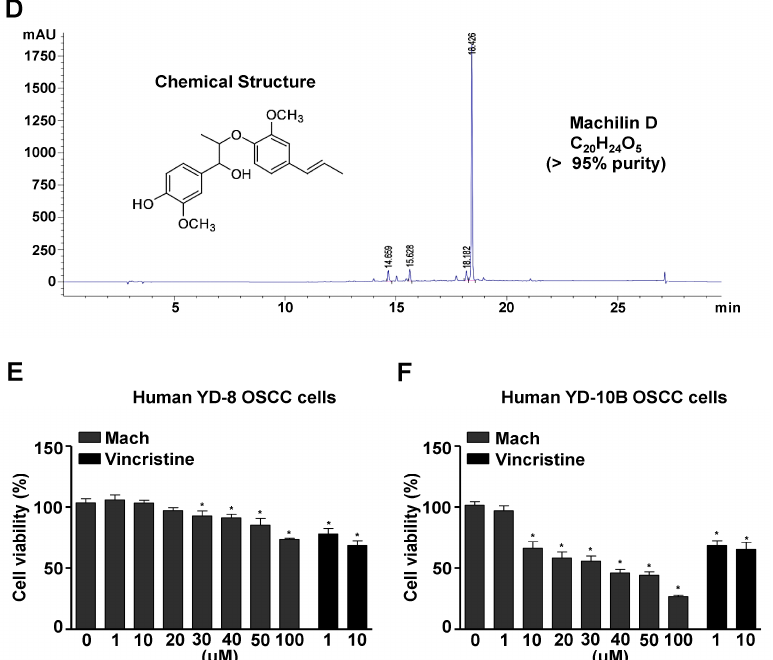
Figure 1. Isolation of Machilin D (Mach) from the roots of Saururus chinensis and its cytotoxic effects on OSCC cells. ( A ) Schematic of the method used to isolate and purify Mach from the roots of S. chinensis . ( B , C ) The 1 H-NMR (500 MHz, CDCl 3 ) ( B ) and 13 C-NMR (125 MHz, CDCl 3 ) ( C ) spectra of Mach. ( D ) HPLC analysis of purified Mach. The chemical structure, purity, and molecular formula of Mach are shown (inset). ( E , F ) Cell viability (%) was measured using the MTT assay after treatment with Mach (1, 10, 20, 30, 40, 50, and 100 µ M) or Vincristine (1 and 10 µ M) for 24 h in human YD-8 OSCC cells ( E ) and YD-10B OSCC cells ( F ). Data are the mean ± SEM. Statistical significance was analyzed using Student’s unpaired t -test. Asterisks indicate statistical significance (* p < 0.05).